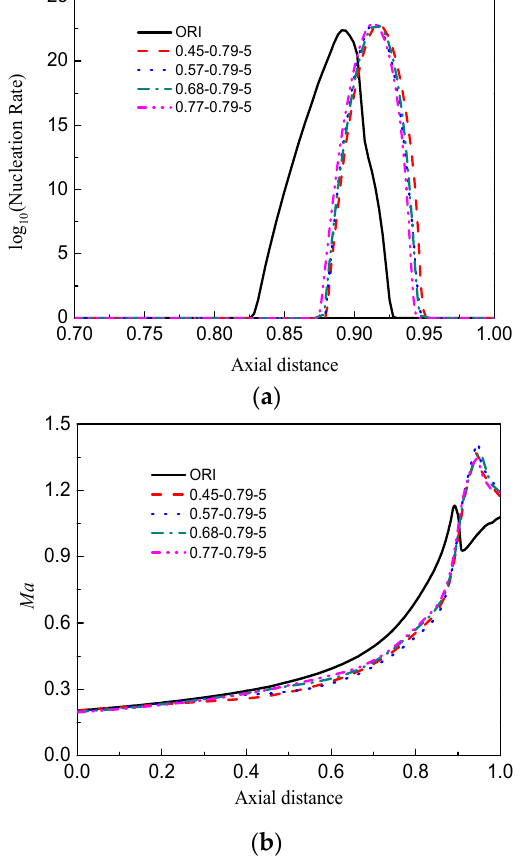
Figure 8. Distribution of steam parameters in the middle of the cascade passage (part 2): ( a ) nucleation rate; ( b ) Mach number.